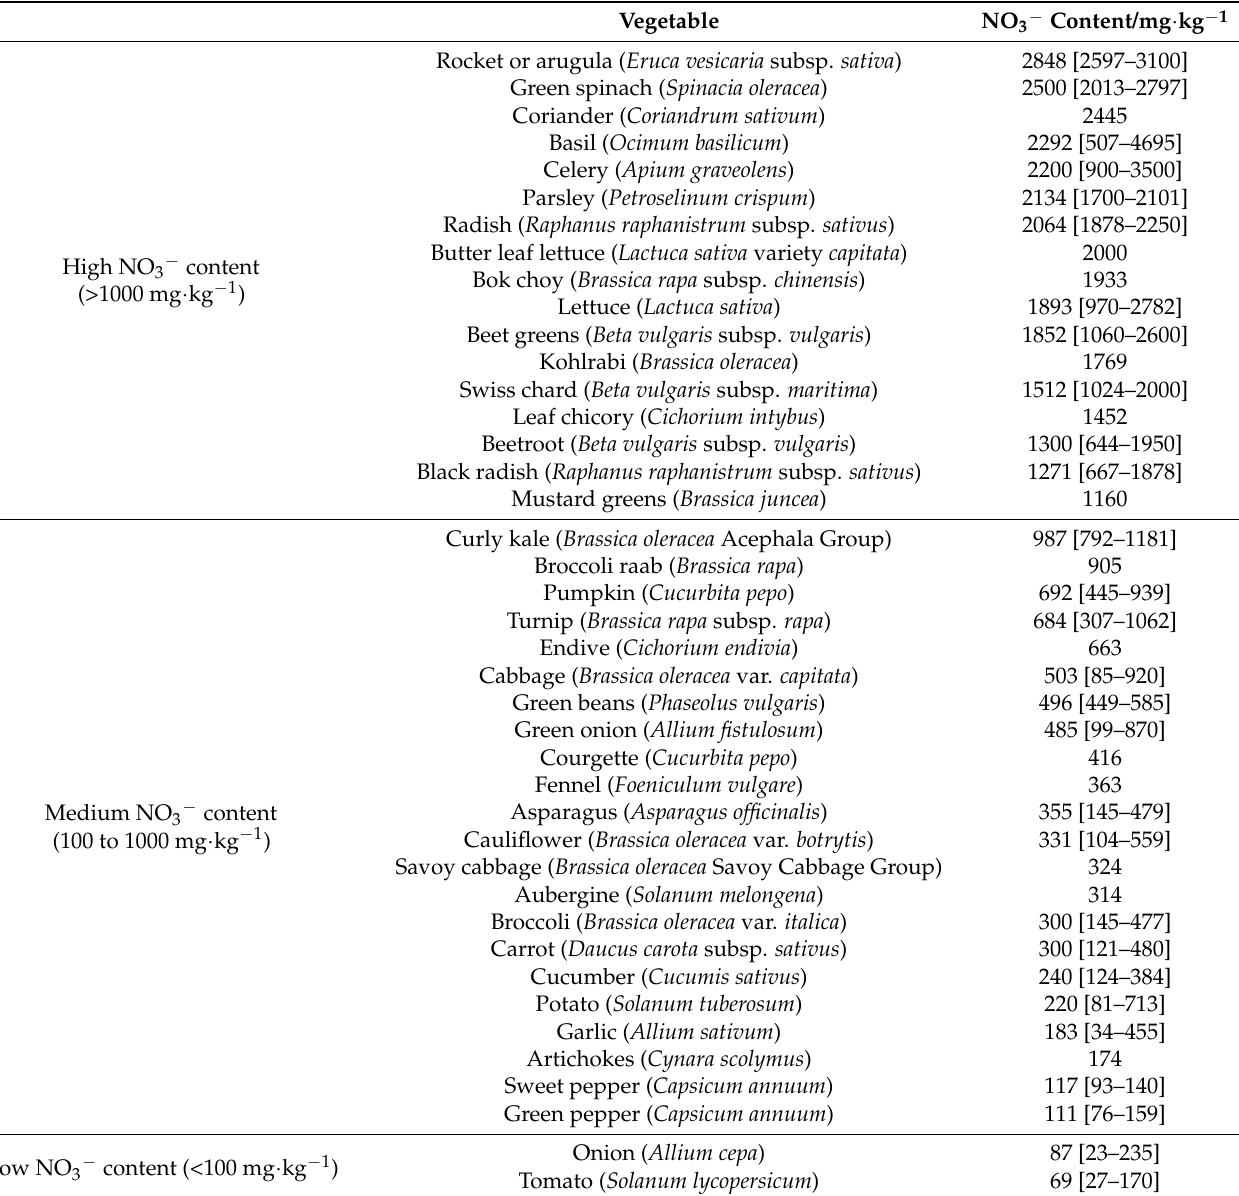
Table 1. Dietary NO 3 − sources classified from the highest to the lowest according to mean [and range] NO 3 − content.